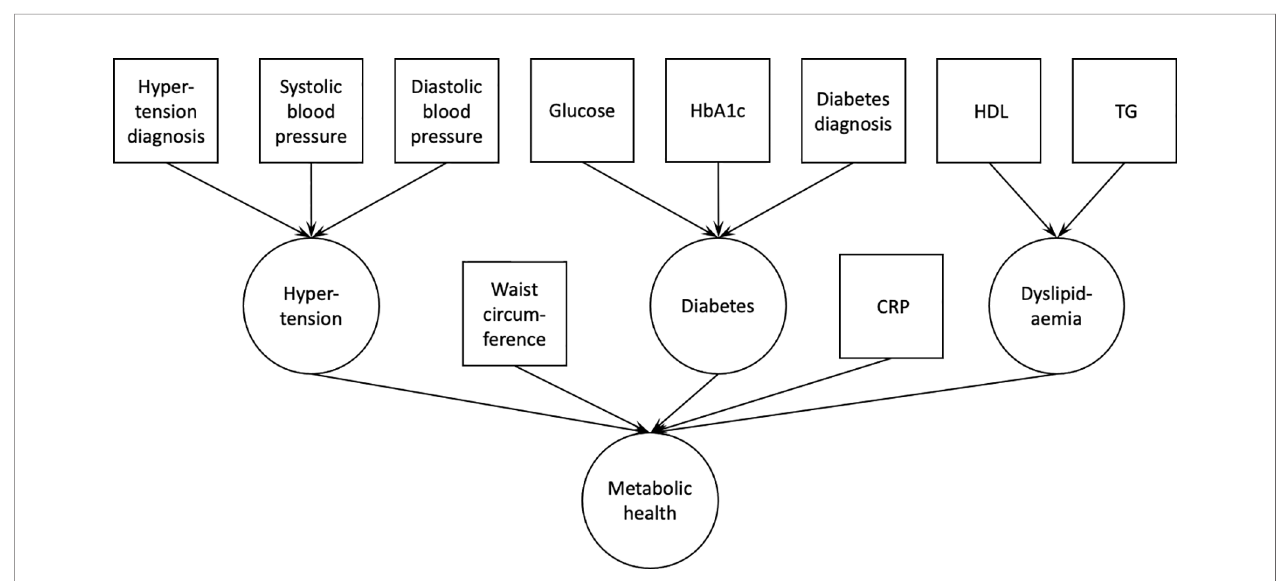
FIGURE 1 | Con fi rmatory factor analysis model used to derive the latent variable ‘ metabolic health ’ . Squares indicate measured variables; circles indicate latent variables. HbA1c, glycated hemoglobin A1c; HDL, high density lipoprotein cholesterol; TG, triglycerides; CRP, C-reactive